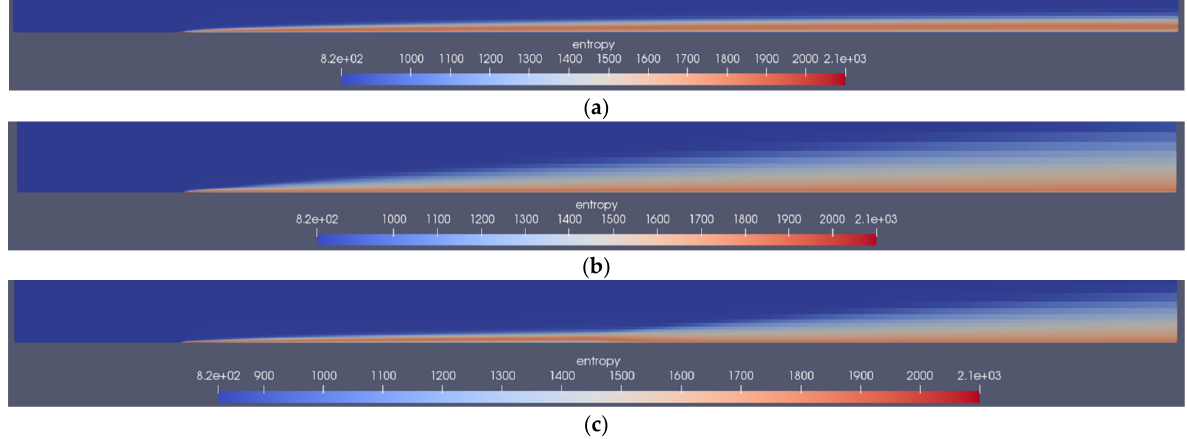
Figure A2. Entropy profile of s00: ( a ) laminar model; ( b ) SA model; ( c ) SA-BCM model.